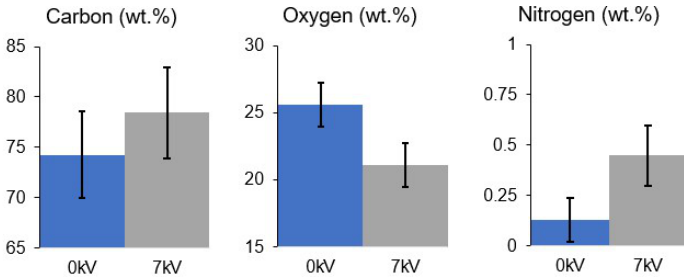
Figure 11. Energy dispersive microanalysis ( EDX) results for the ACC before and after the